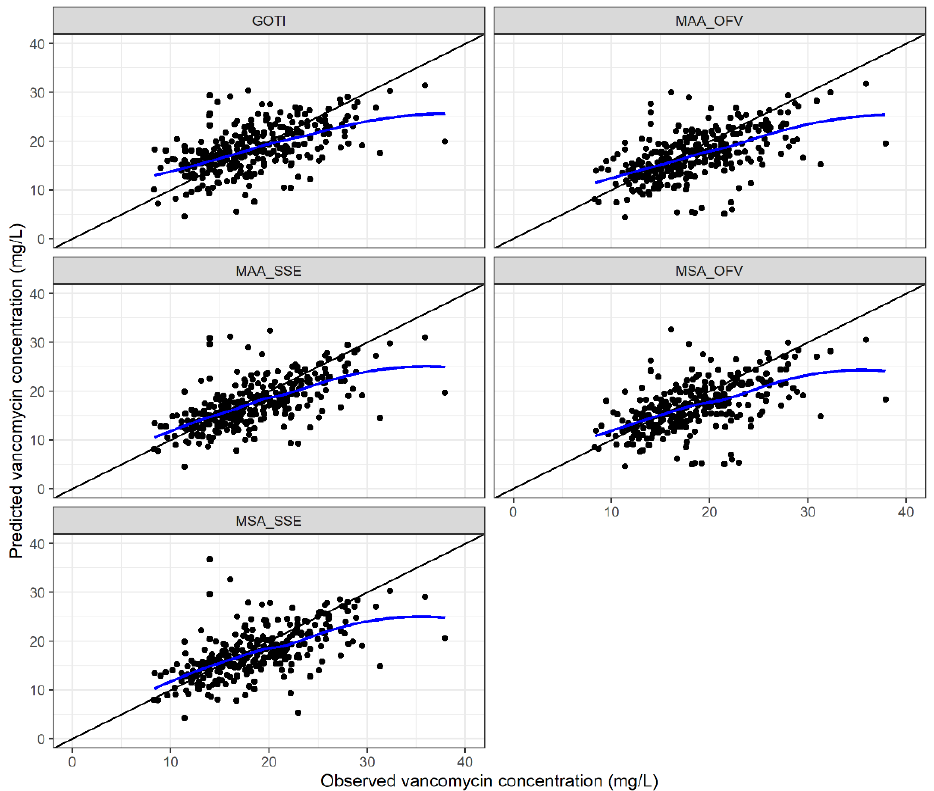
Figure 3. Goodness-of-fit plots of the predicted versus observed second vancomycin concentration of each pair for the five model-based approaches (i.e., the model selection algorithm [MSA] and the model averaging algorithm [MAA], according to the objective function value [OFV] and the squared prediction errors [SSE], and the single-model approach according to the Goti model). The blue line represents the local polynomial regression fit. The line of identity represents a perfect model fit.